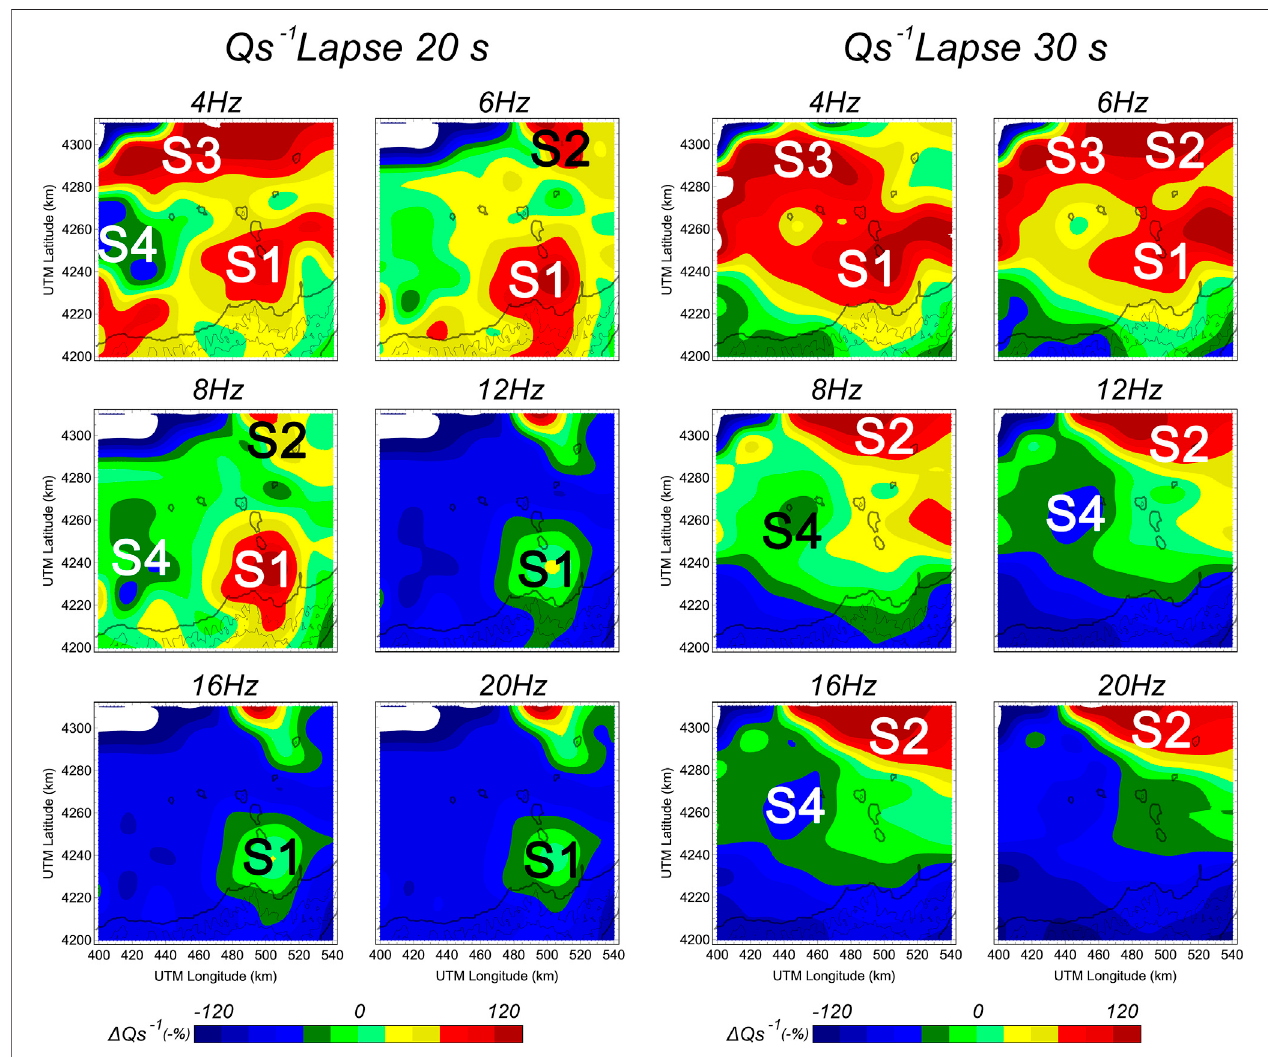
FIGURE 10 | Maps of scattering attenuation (represented by Qs − 1 ) for all analysed frequency bands. Maps are given for two lapse times: (A) 20 s and (B) 30 s.